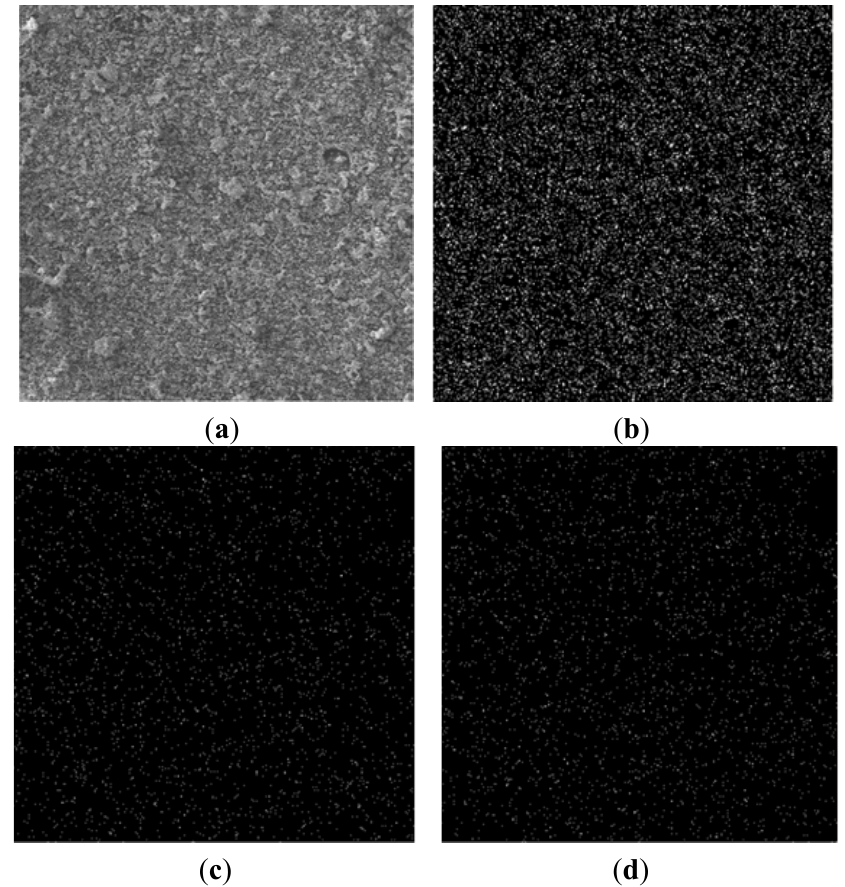
Figure 6. X-ray mapping of Ni-10wt%Al ( a ) SEM micrograph; ( b ) mapping of nickel; ( c ) aluminum; and ( d ) oxygen [71].